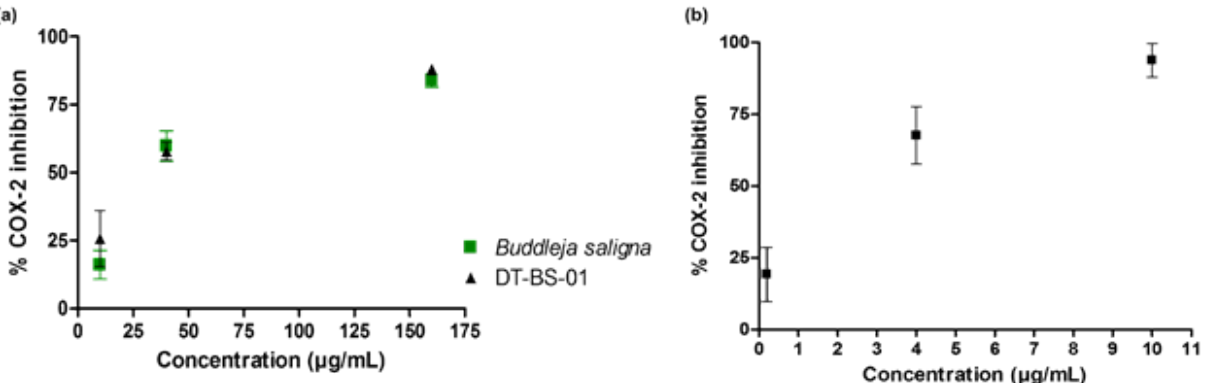
Figure 5. Dose—response curves of ( a ) Buddleja saligna (10, 40 and 160 µ g/mL) and DT-BS-01 Figure 5. Dose − response curves of ( a ) Buddleja saligna (10, 40 and 160 µg/mL) and DT − BS − 01 (10, 40 (10, 40 and 160 µ g/mL) on COX-2 mediated PGE 2 production compared to the positive control, and 160 µg/mL) on COX − 2 mediated PGE 2 production compared to the positive control, ( b ) Ibu- ( b ) Ibuprofen (0.2, 4 and 10 µ M). Data shown are mean ± SD ( n = profen (0.2, 4 and 10 µM). Data shown are mean ± SD ( n = 3).